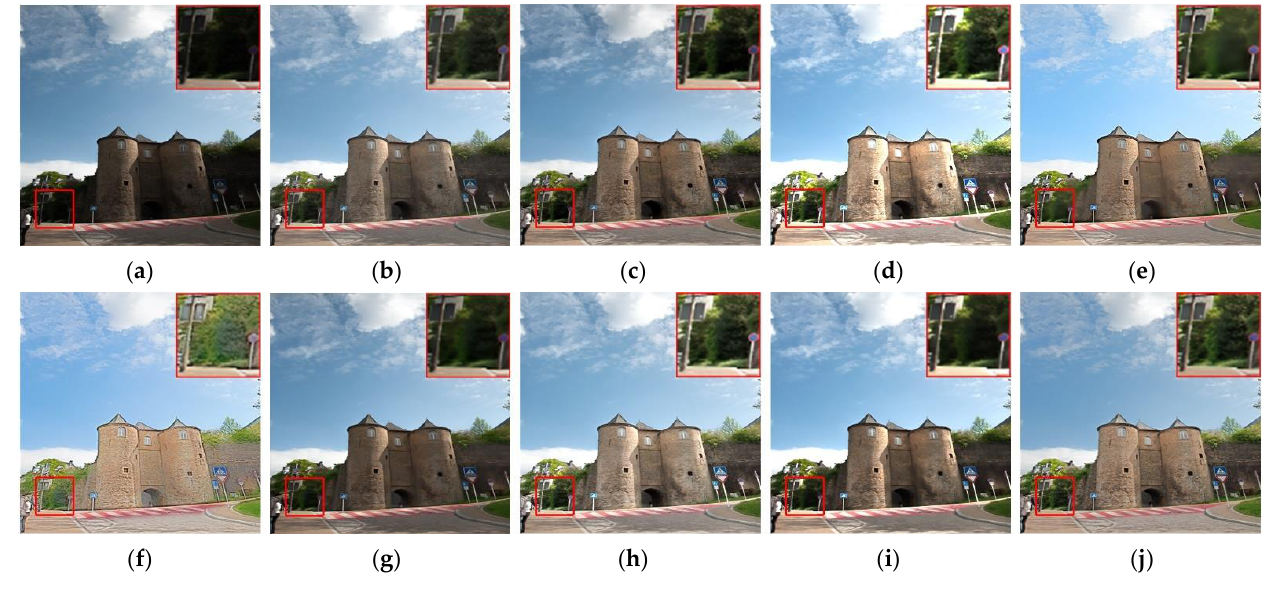
Figure 14. Enhanced results of “Tree” image. ( a ) Original image; ( b ) BIMEF; ( c ) MEF; ( d ) LIME; ( e ) SR;